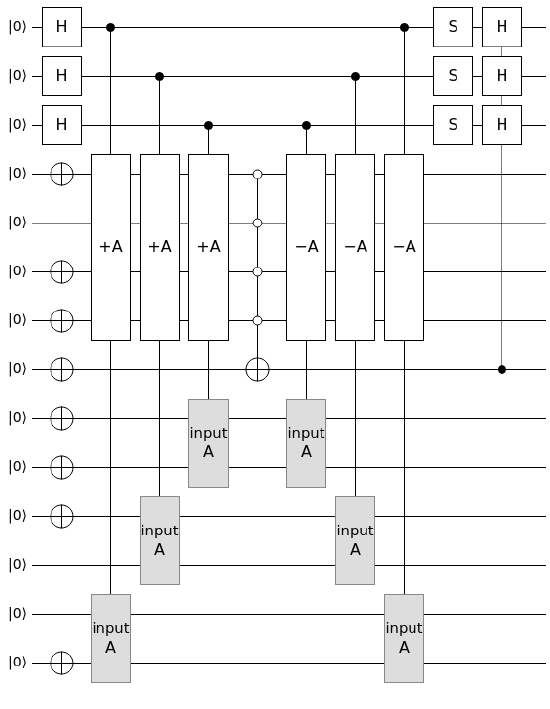
Figure 3. An instance of PP in